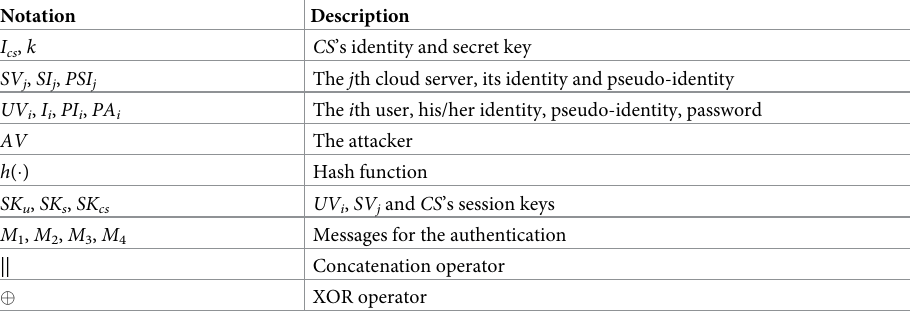
Table 2. Notations in Zhou et al.’s